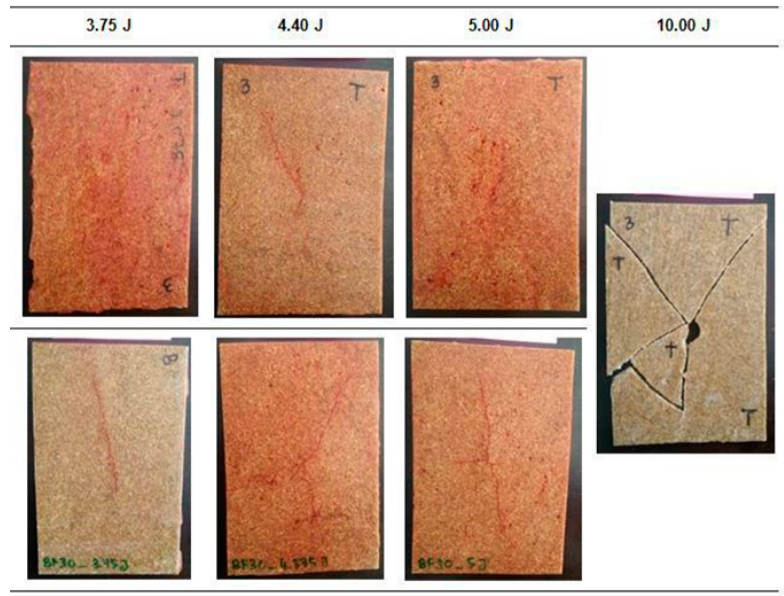
Figure10. ThedamageontheimpactedsamplesofEP-BF30wasobservedwiththehelpofdyepenetrant. Figure 10. The damage on the impacted samples of EP-BF30 was observed with the help of dye penetrant.